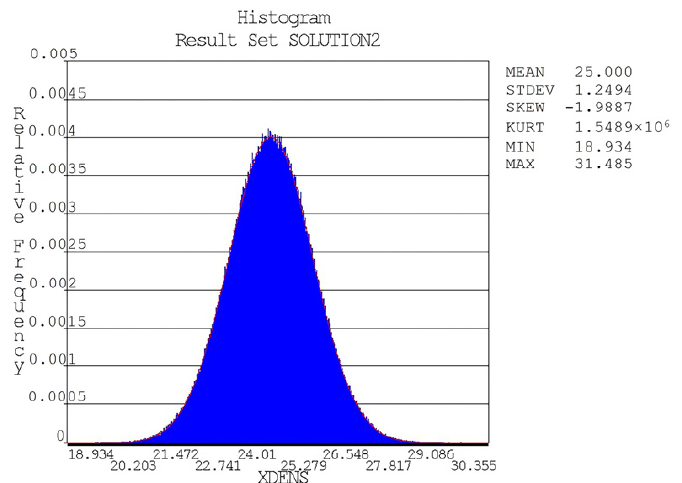
Figure 20. XDENS random sampling.